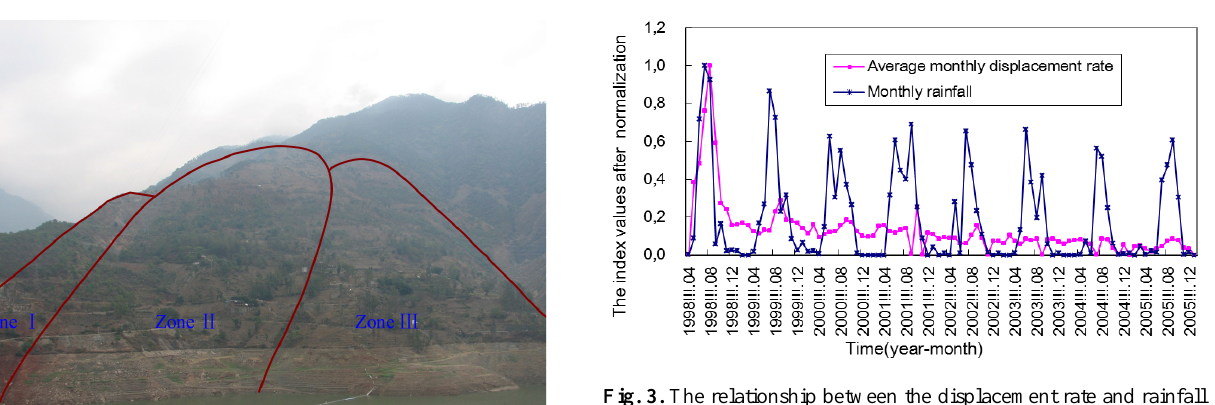
Fig. 3. The relationship between the displacement rate and rainfall for the landslide.